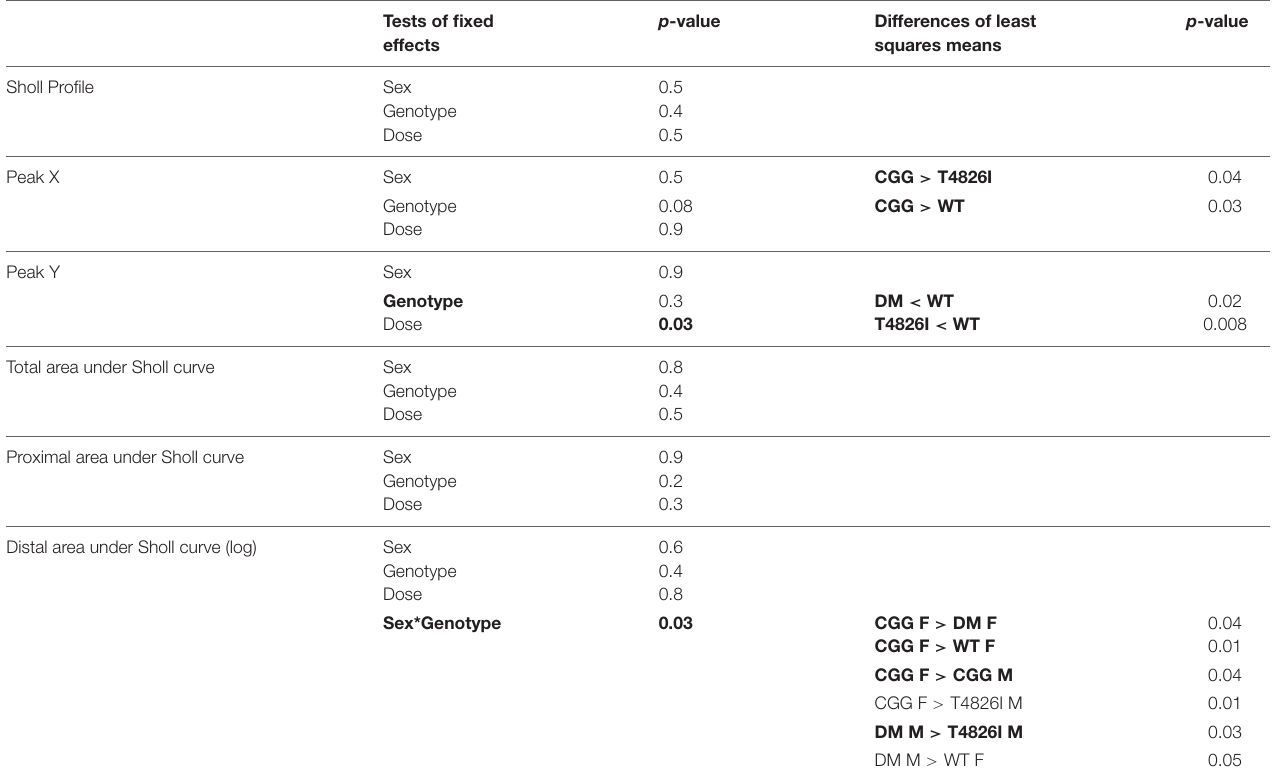
TABLE 1 | Summary of mixed model effects in pyramidal CA1 hippocampal